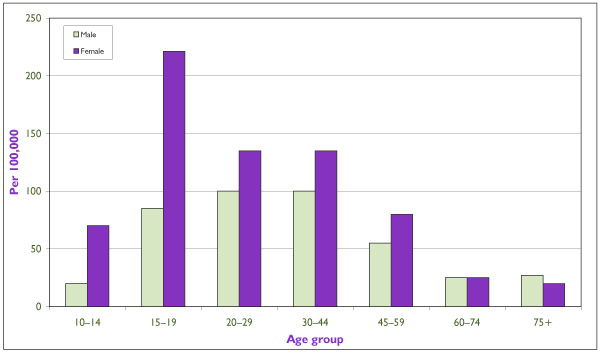
Age-specific hospitalization rates for suicide attempts, by sex, Canada, 1998–1999 Source: Hospital Morbidity Database, 1998–1999 (Health Rep 2002;13(2))